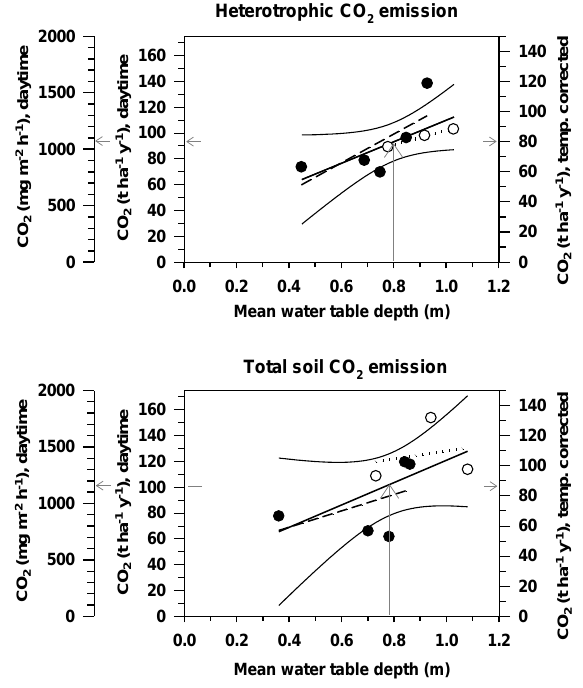
Fig. 3. Regression of mean peat surface CO 2 emission from heterotrophic respiration at furthest from trees locations (upper graph) and mean total soil CO 2 emission at nearest to trees locations (lower graph) at mean water table depths at the monitoring transects. Emission values provided in multiple units; daytime emission values (mg m -2 h -1 , t ha -1 y -1 ) on the left axis, and temperature corrected emissions (t ha -1 y -1 ) on the right axis. Linear regression lines for ≤16 months old trees (○-symbol, dotted line), ≥24 months old Acacia (●-symbol, dashed line), average (solid line), and 95% confidence limits (solid curves) for the combined data from 8 transects are provided. Arrows indicate regression mean emissions and water table depths.